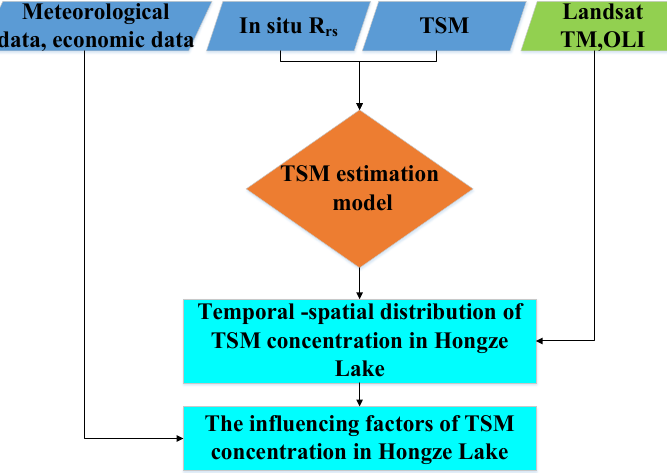
Figure 2. Flow chart of this study.